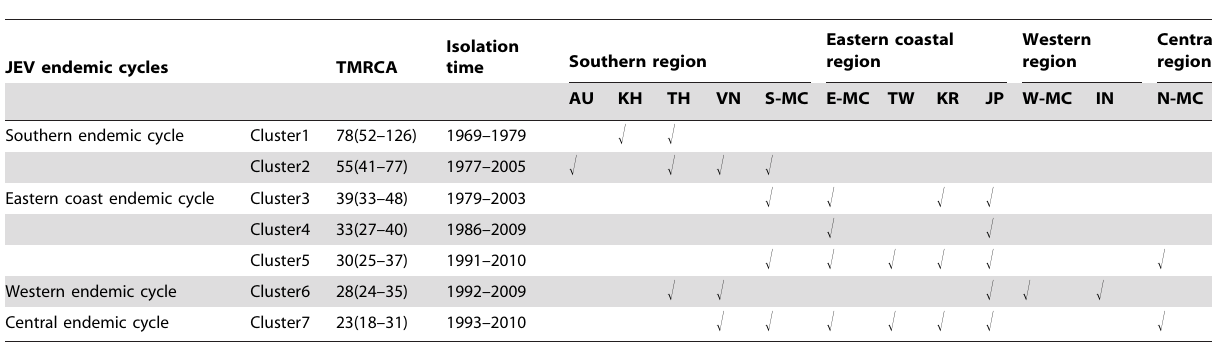
Table 1. The regional distribution of JEV (genotype 1) isolates in four endemic cycles.